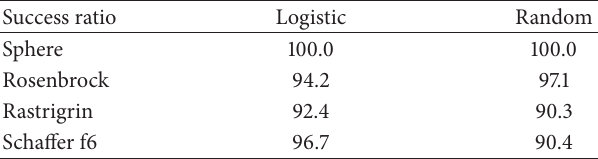
Table 1: The search success ratio of functions (%) [26]. Success ratio